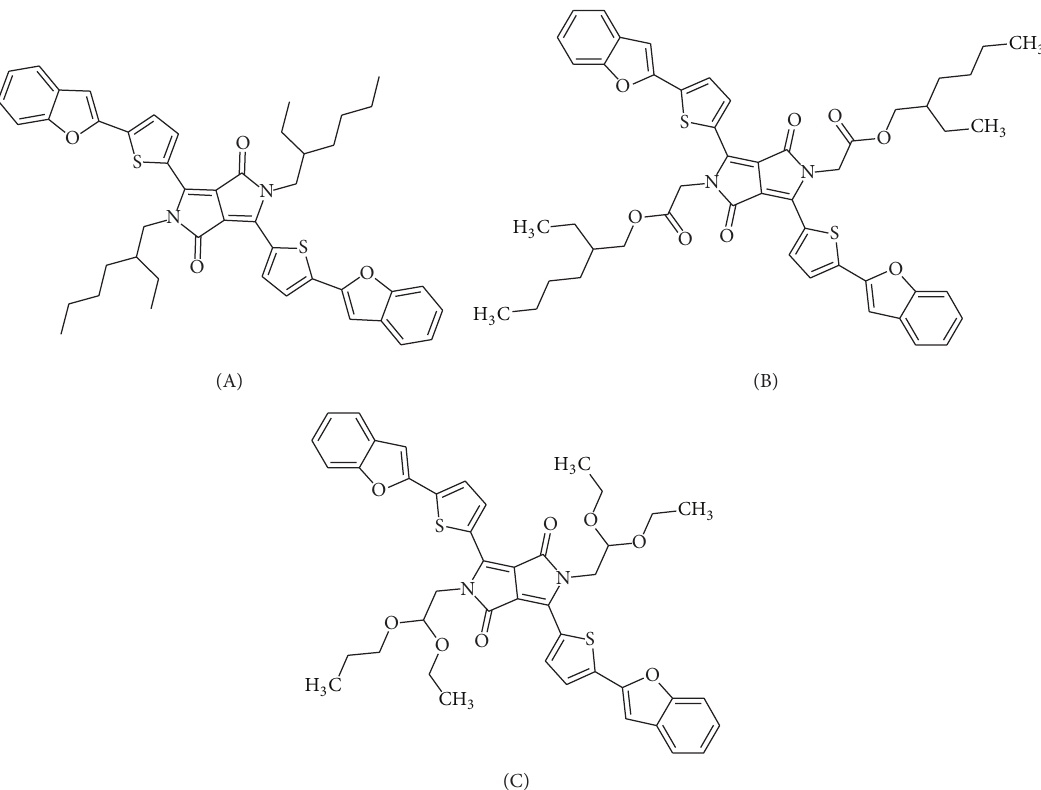
Figure 1: DPP(TBFu) 2 derivatives substituted with ethyl-hexyl (A), ethyl-hexyl acetate (B), and diethyl acetal (C) solubilization groups.